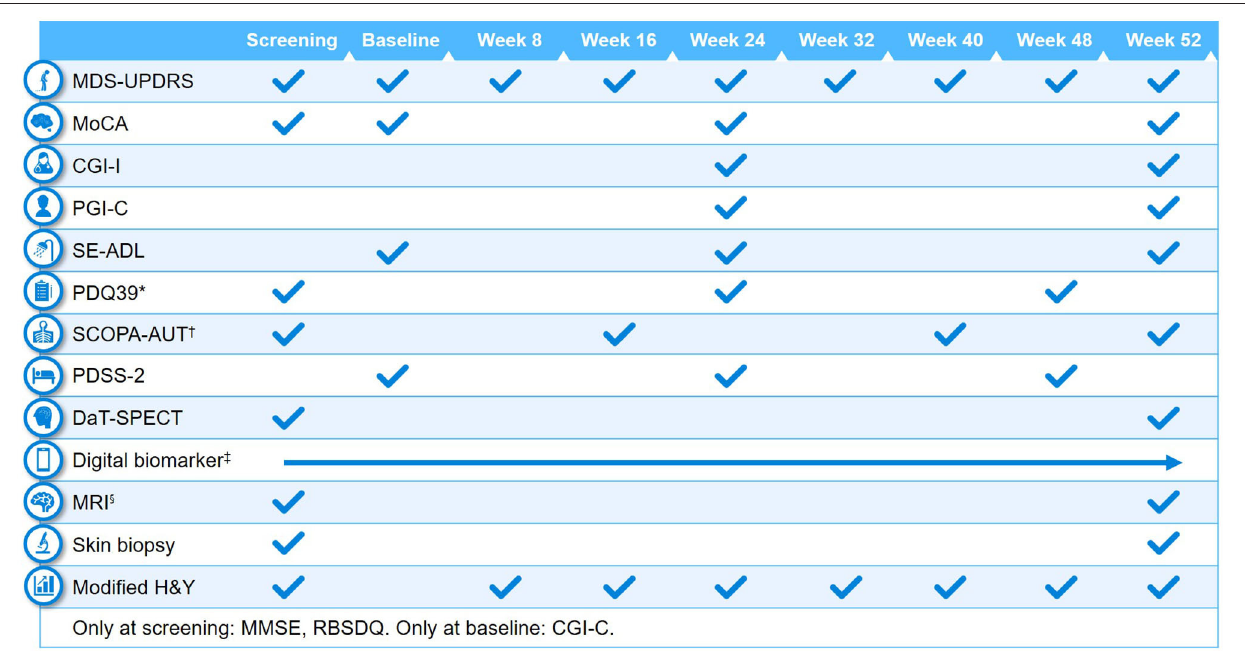
FIGURE 2 | Schedule of activities in PASADENA Part 1. *Parkinson’s Disease Questionnaire − 39 (PDQ39) is at baseline, Week 20, and Week 48; † SCOPA-AUT (Scales for Outcomes in Parkinson’s Disease—Autonomic Dysfunction) is at baseline, Weeks 16, 28, 40 and 52. ‡ Digital includes PASADENA Digital Motor Score, Patient Global Impression of Severity, Daily diary, Patient Assessment of Constipation Symptoms (PAC-SYM), EuroQol-5D (EQ-5D) and Hospital Anxiety and Depression Scale (HADS). § Magnetic resonance imaging (MRI) includes safety, diffusion tensor imaging (DTI), resting state and arterial spin labeling (ASL). CGI-C, Clinical Global Impression of Change; CGI-I, Clinical Global Impression of Improvement; DaT-SPECT, dopamine transporter imaging with single-photon emission computerized tomography; H&Y, Hoehn & Yahr; MDS-UPDRS, Movement Disorder Society—Unified Parkinson’s Disease Rating Scale; MMSE, Mini Mental State Examination; MoCA, Montreal Cognitive Assessment; PDSS-2, Parkinson’s Disease Sleep Scale Revised Version 2; PGI-C, Patient Global Impression of Change; RBDSQ, Rapid Eye Movement Sleep Behavior Disorder Screening Questionnaire; SE-ADL, Schwab and England Activities of Daily